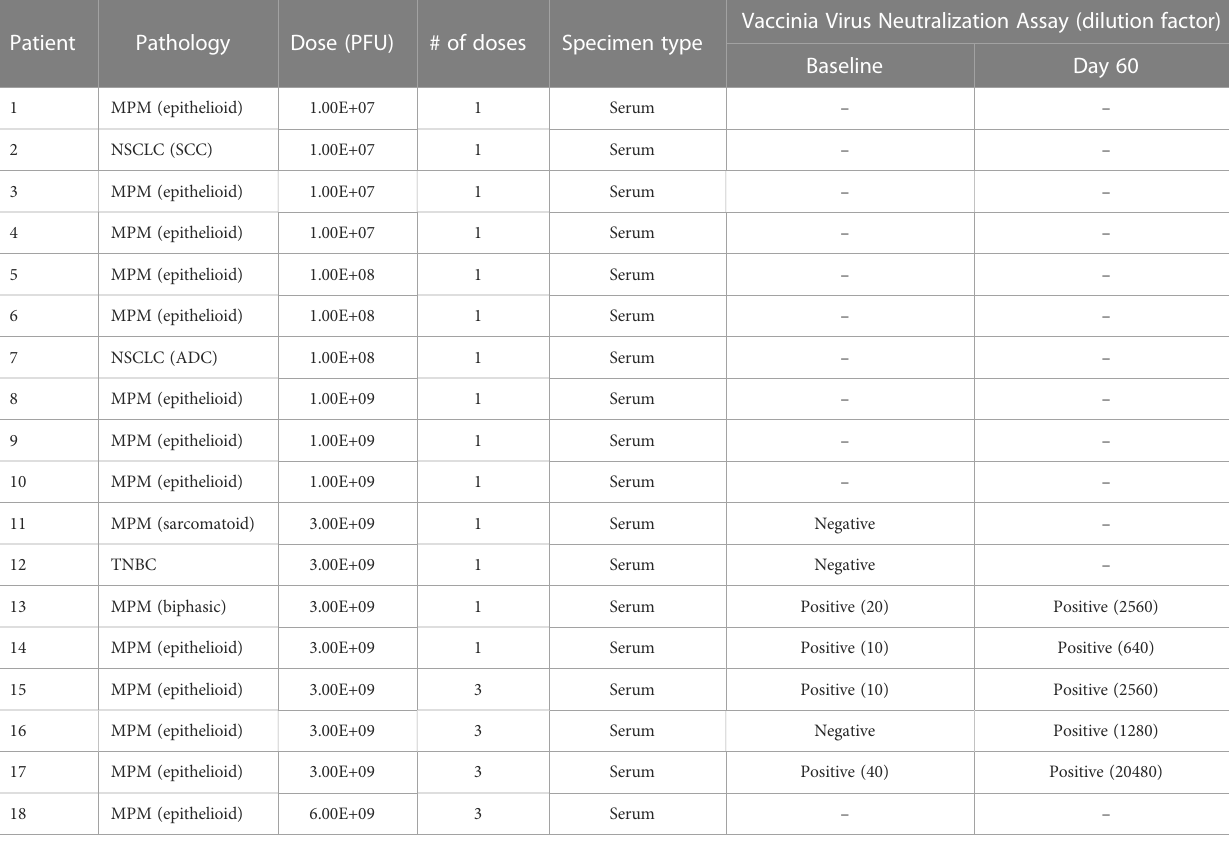
– Insuf fi cient sample ADC, adenocarcinoma; MPM, malignant pleural mesothelioma; NSCLC, non-small cell lung cancer; PFU, plaque-forming units; SCC, squamous cell carcinoma; TNBC, triple negative breast cancer.